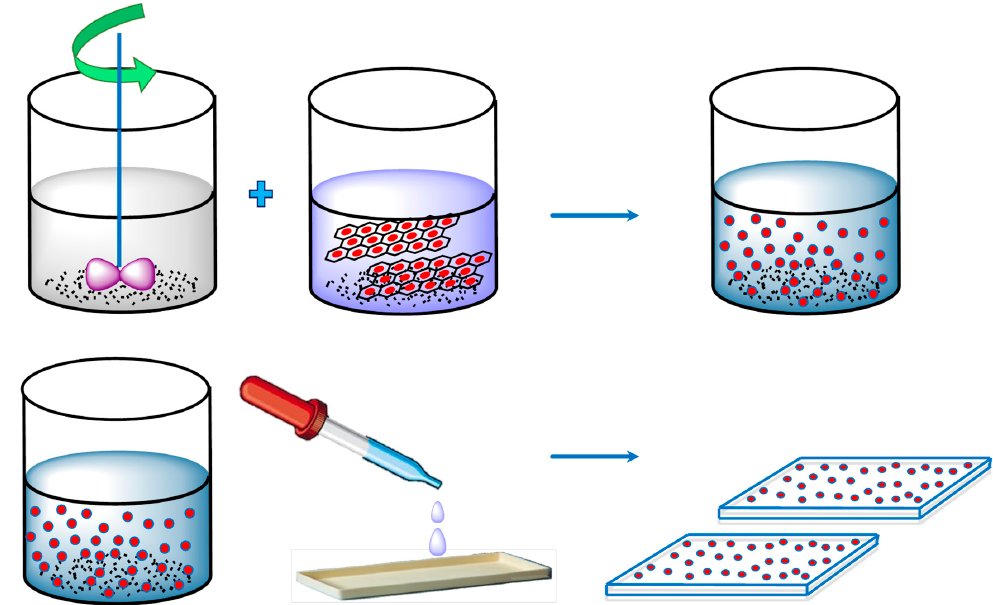
Figure 8. Preparation of membrane by solution mixing and casting.